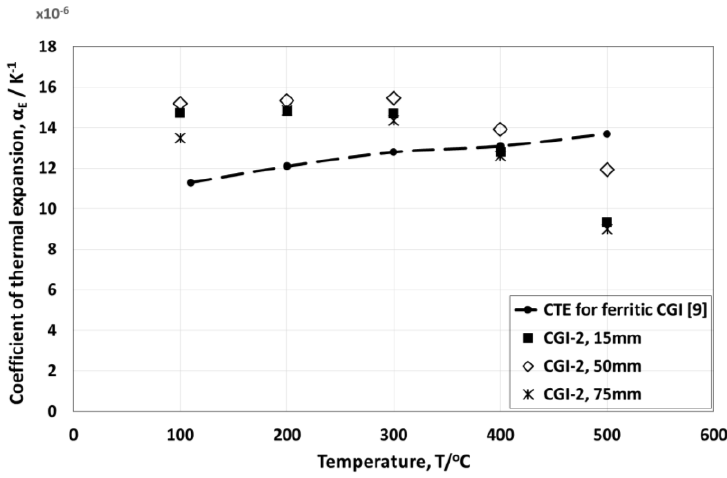
Figure 9. CTE of SGI-2 (15, 50 and 75 mm) as a function of temperature (during heating cycles). The SGI-2 samples are fully ferritic. In this case, the results can be explained by the graphite amount in the microstructure. As shown in Table 3, the graphite amount in SGI-2, 15, 50 and 75 mm, are 2.12%, 6.78% and 5.57%, respectively, and the CTE is decreasing with increasing graphite (which has much lower CTE than matrix) amounts (Figure 9). The matrices of SGI-2 samples are 100% ferritic. Therefore, there is no influence of the ferrite/pearlite ratio and graphite amount is a dominant factor. On the other hand, in the case of ferrite/pearlite matrix (SGI-3 in Figure 8), the samples that have higher graphite amounts (SGI-3, 50 mm and 75 mm) show higher CTE. This opposite trend indicates that the ferrite/pearlite ratio plays a more important role than graphite amount.